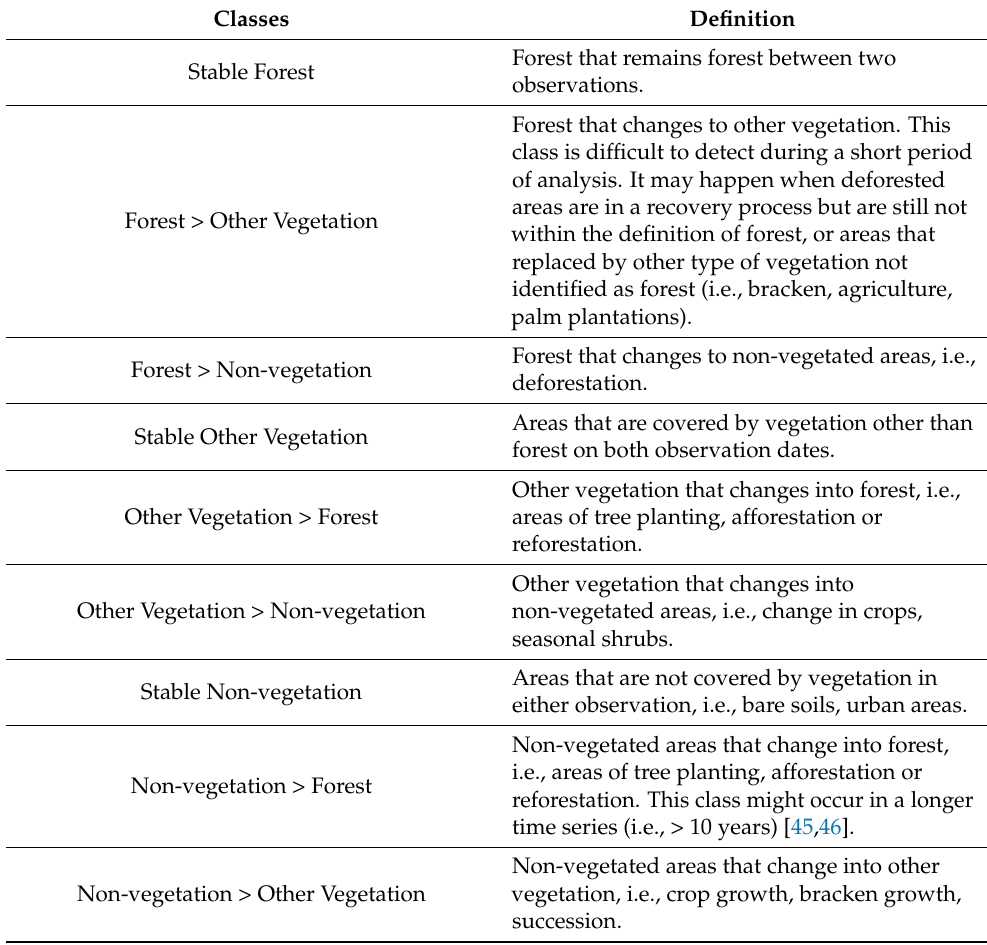
Table 1. The definitions of change classes considered in the NRT change detection